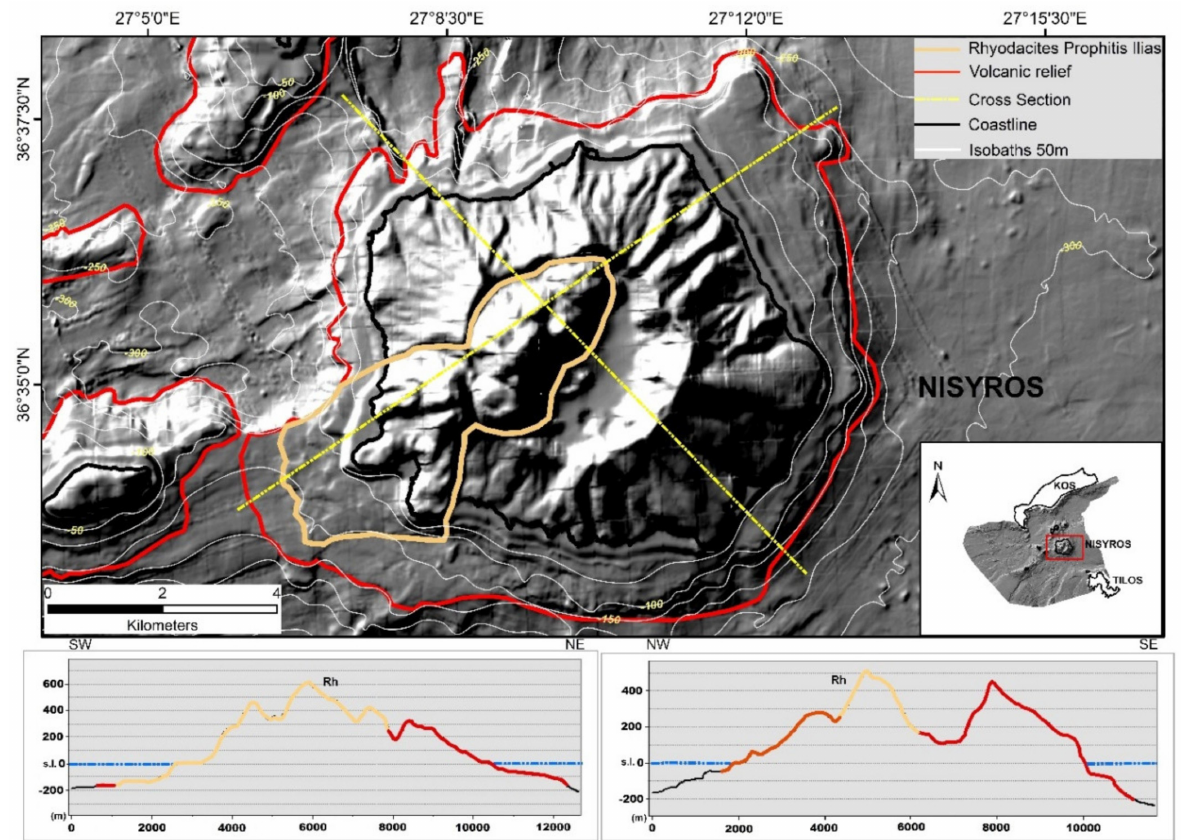
Figure 6. The Nisyros volcano consists of the older stratovolcano structure with the distinctive central caldera (in red) and the younger Prophitis Ilias (Rh) postcaldera rhyodacitic domes (in orange). The two topographic profiles depict the onshore/offshore Nisyros volcanic relief. Table 1. Geometric characteristics of volcanic structures of the study area estimated using 3d geoprocessing tools.